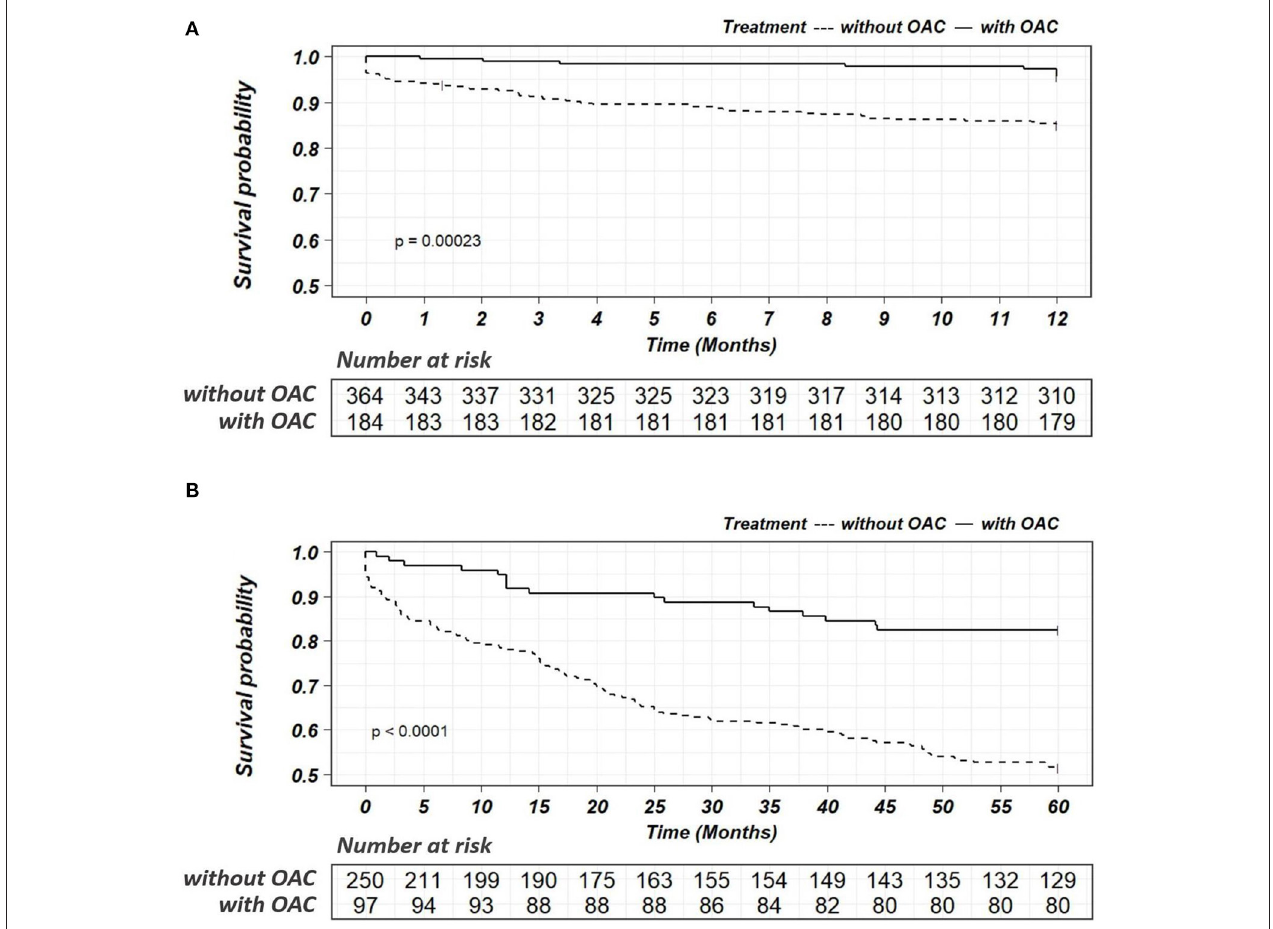
FIGURE 5 | Kaplan-Meier survival curves for the endpoints of MACEs within a follow-up of 1 year (A) or 5 years (B) in patients with or without OAC. OAC, oral anticoagulant.